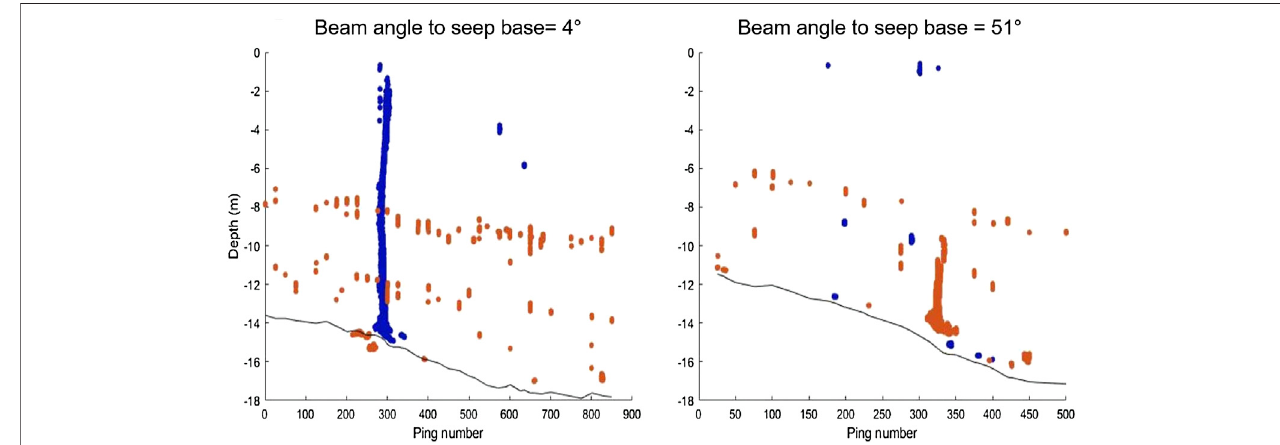
FIGURE 6 | 2-D quality control fi gures generated from fi ltering work fl ow. (A) shows a survey line with the gas seep located near nadir (4 ° ), and (B) shows a survey linewiththegasseepbaselocatedat51 ° .Baseangleisthebeampointingangletothebaseofthegasseepatthesea fl oor.ThebluepointsindicatetargetswithinMSR A , andtheorangepointsindicatetargetswithinMSR B (fullywithinsidelobeinterference).Blacklinesindicatebottomdetectionsfromthenadirbeam.Intheseimagestargets across all beams are overplotted at each ping number to compress the image from 3-D to 2-D.